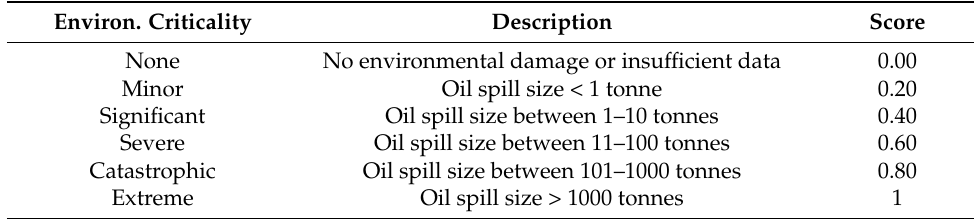
Table 7. Estimation criteria for environmental criticality.